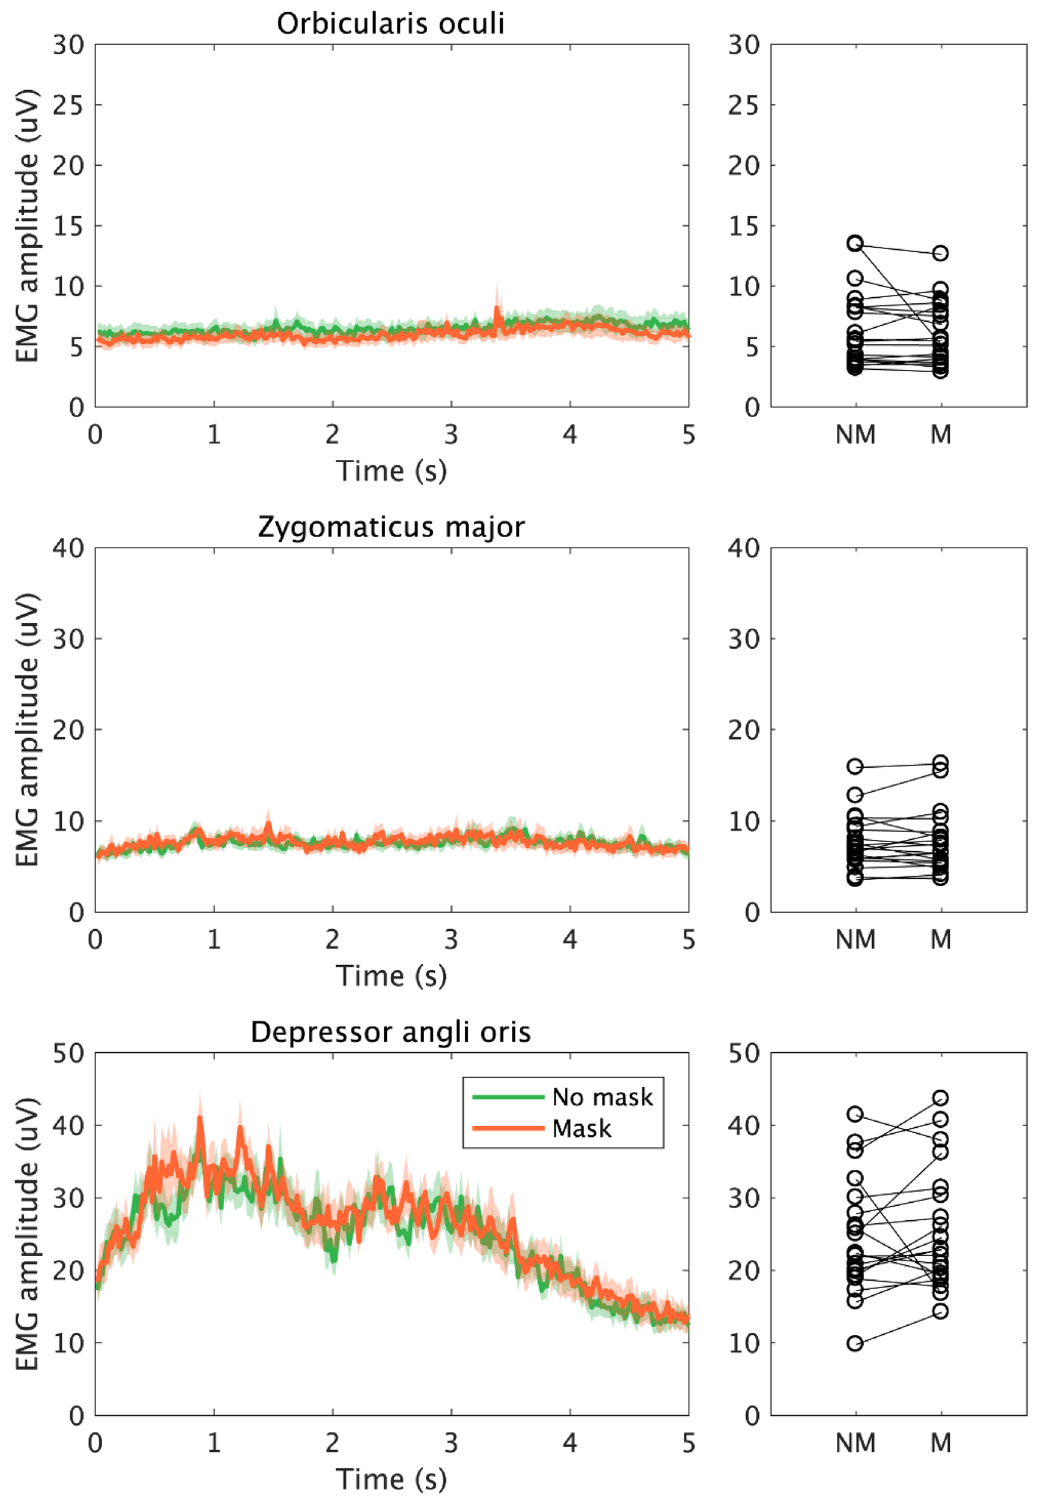
Figure 4. EMG signal measured over orbicularis oculi, zygomaticus major, and depressor anguli oris, during the reading task (5 s). Plots and colours are the same as in Fig. 2. There were no significant changes in the muscle activity of the three muscles in the reading